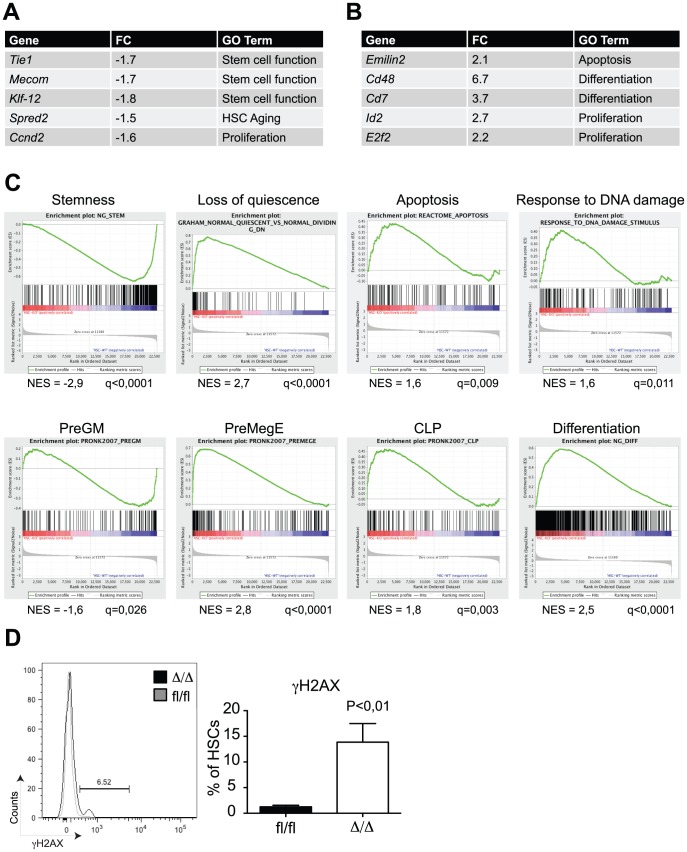
Gene expression profiling of Cebpa
Δ/Δ HSCs shows loss of stemness and biased lineage differentiation.(A) HSCs from Cebpa
Δ/Δ and Cebpa
fl/fl mice were subjected to gene expression analysis. The table shows selected genes downregulated in Cebpa
Δ/Δ compared to Cebpa
fl/fl HSCs. (B) Selected genes upregulated in Cebpa
Δ/Δ compared to Cebpa
fl/fl HSCs. (C) Gene set enrichment analysis of Cebpa
Δ/Δ HSCs compared to Cebpa
fl/fl HSCs. (D) DNA damage as assessed by γH2AX staining of Cebpa
Δ/Δ (n = 9) and Cebpa
fl/fl (n = 8) HSCs. Data are represented as mean+SEM.